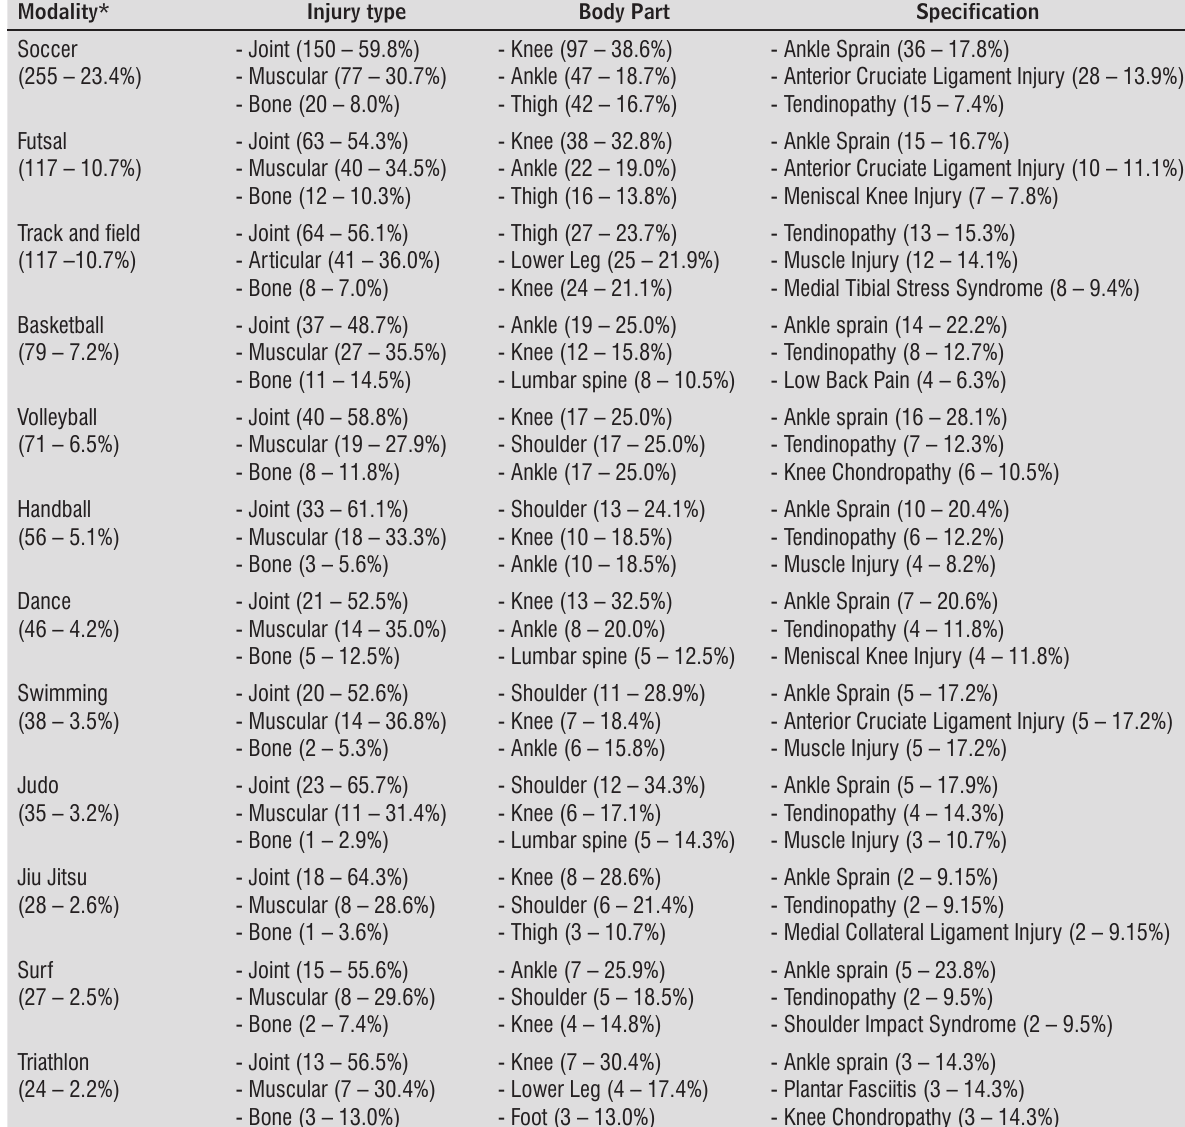
Table 1 - Injury frequency related to